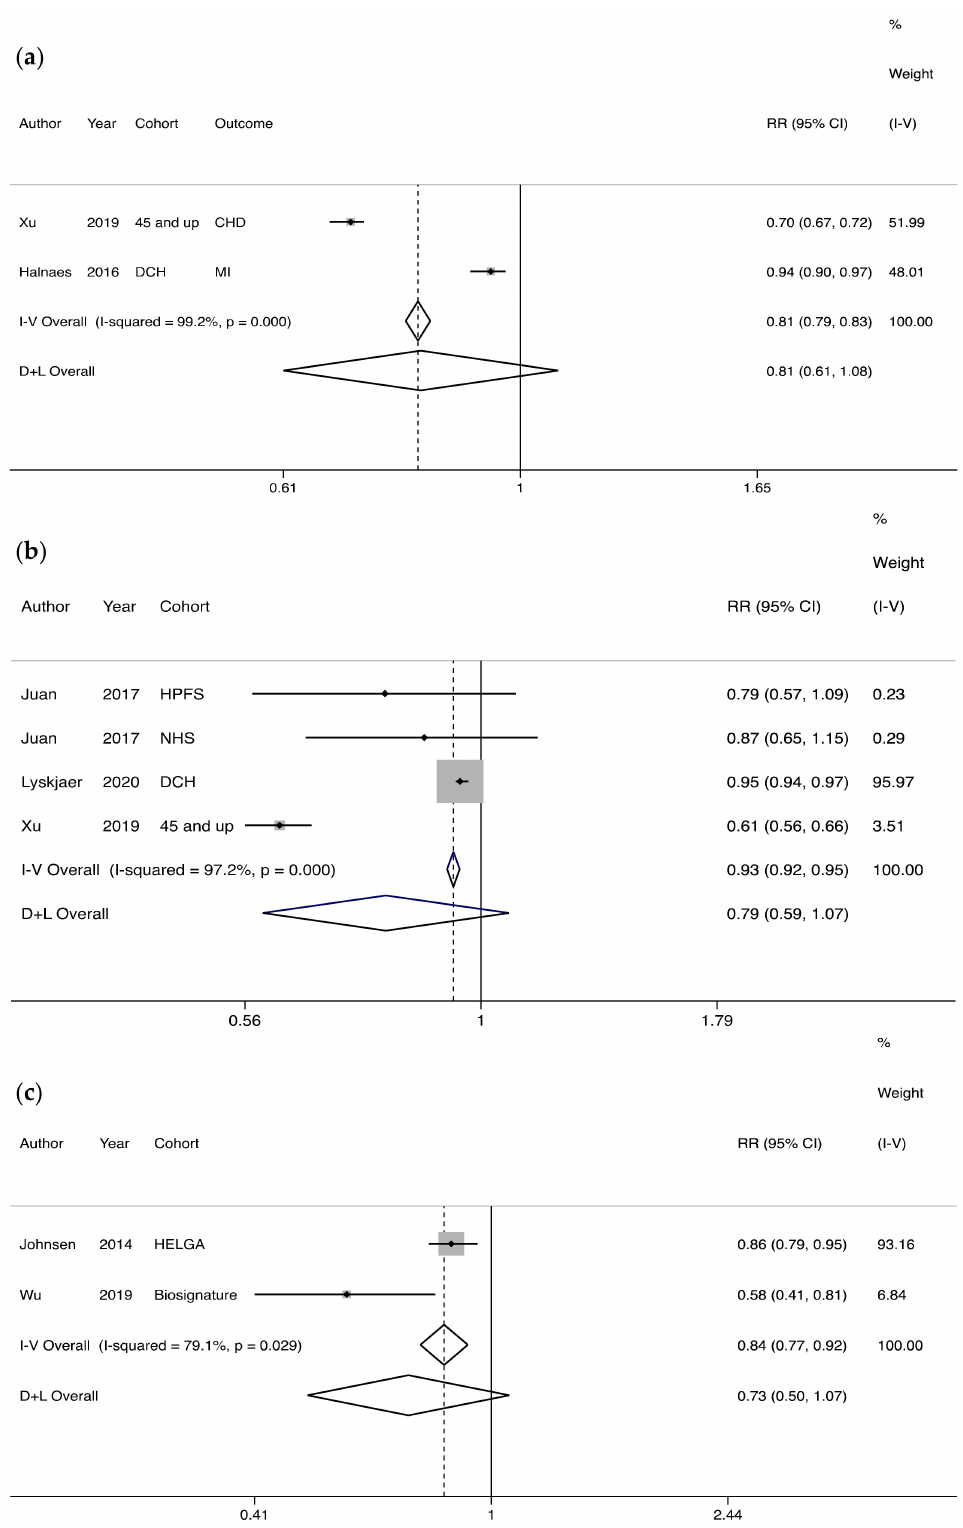
Figure 4. The association between oat consumption and risk of cardiovascular disease. ( a ). The association between oat consumption and risk of cardiovascular disease. Participants with highest vs. lowest oat consumption are compared. CHD–coronary heart disease, MI–myocardial infraction. ( b ). The association between oat consumption and risk of stroke. Participants with highest vs. lowest oat consumption are compared. ( c ). The association between oat consumption and risk of composite cardiovascular disease. Consumers vs. non-consumers are compared. I–V: inverse-variance estimation, random effect model. D + L: DerSimonian–Laird (DL) method, fixed effect model